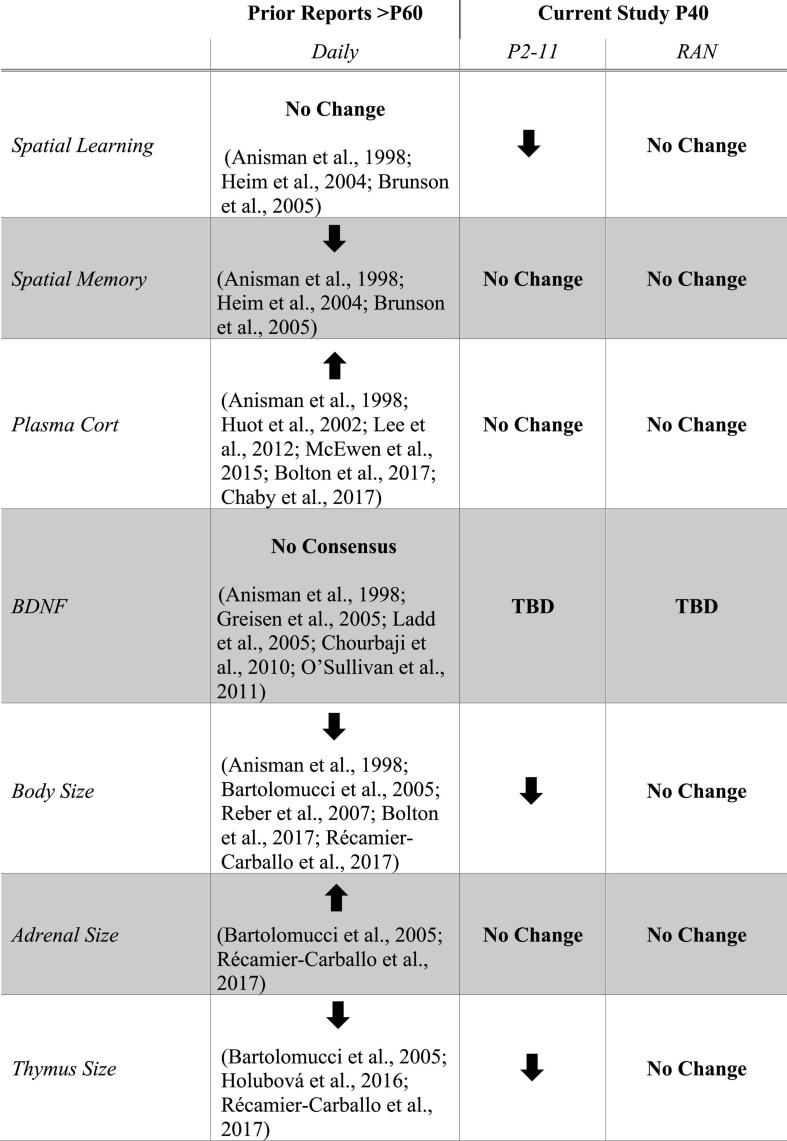
Table listing results from prior studies of MD with daily separation side-by-side with the current study. The Prior Reports column shows the consensus of research studies utilizing a daily (Daily) separation schedule with assays performed in adulthood (Anisman et al., 1998; Huot et al., 2002; Heim et al., 2004; Bartolomucci et al., 2005; Brunson et al., 2005; Greisen et al., 2005; Ladd et al., 2005; Reber et al., 2007; Chourbaji et al., 2010; O’Sullivan et al., 2011; Lee et al., 2012; McEwen et al., 2015; Holubová et al., 2016; Bolton et al., 2017; Chaby et al., 2017; Récamier-Carballo et al., 2017). The Current Study columns summarize the results from the P2–11 and RAN separation schedules. Arrows indicate direction of change in each parameter relative to non-stressed controls. No Change indicates that there is no difference between stressed and non-stressed controls. No Consensus indicates that there is no clear agreement in the literature. TBD indicates “to be determined.”